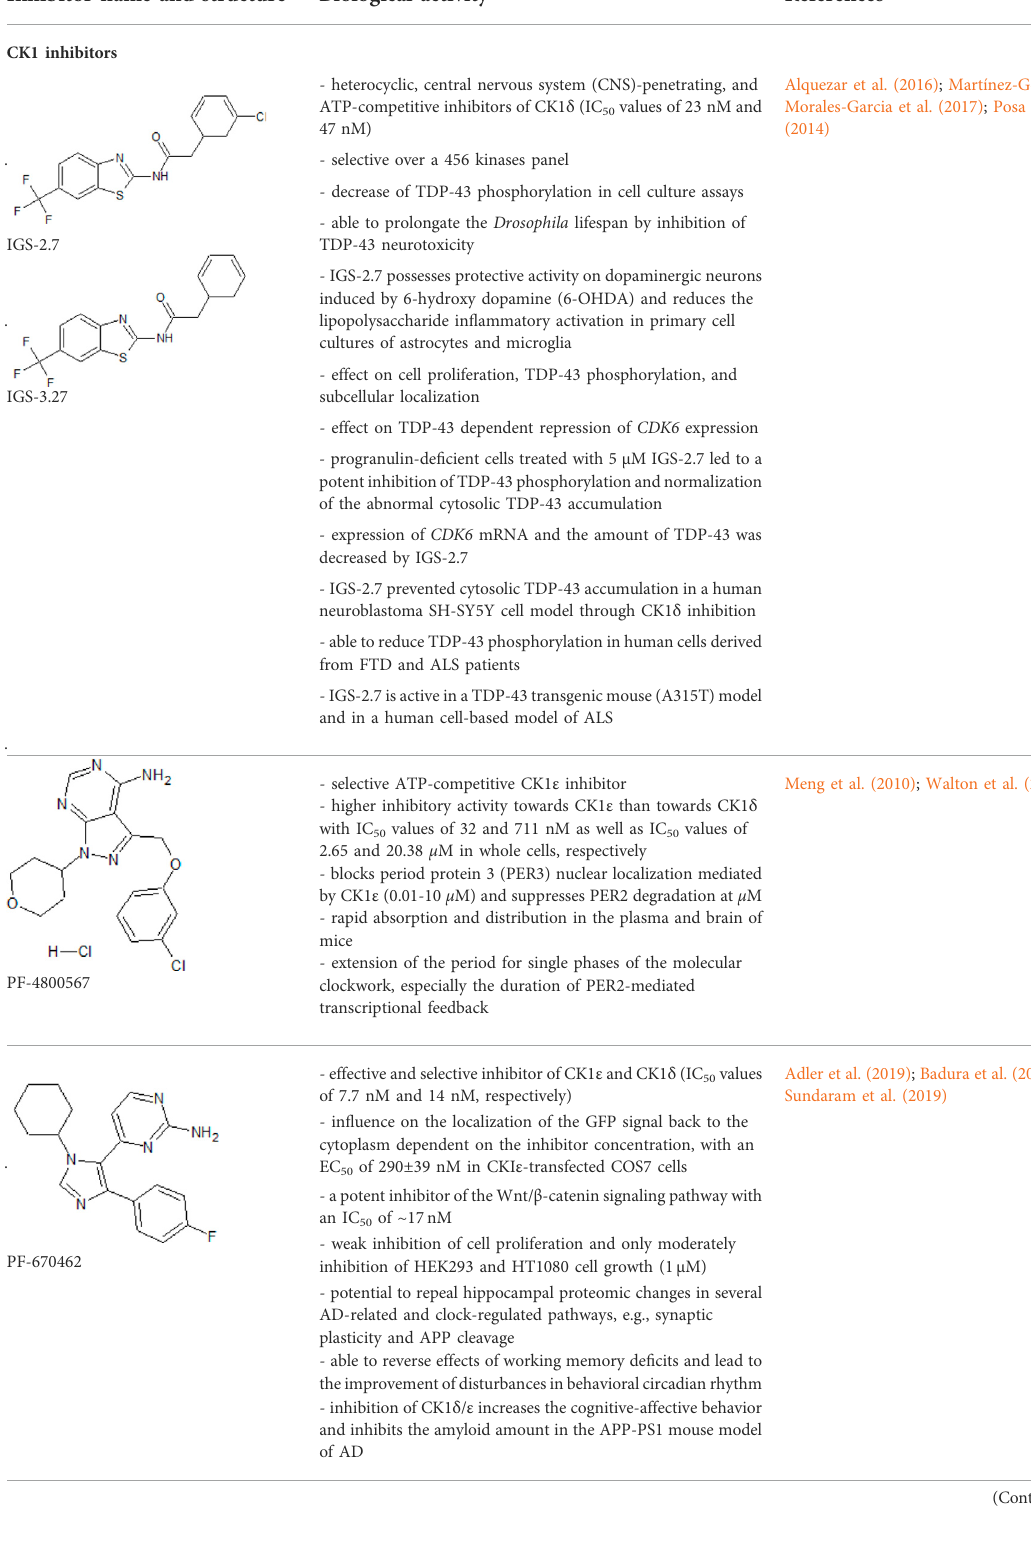
TABLE 2 Inhibitors of CK1, TTBK, and